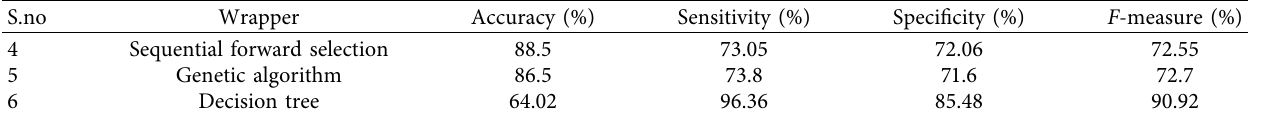
Table 4: Top 3 feature selection methods (wrapper) based on high performance.